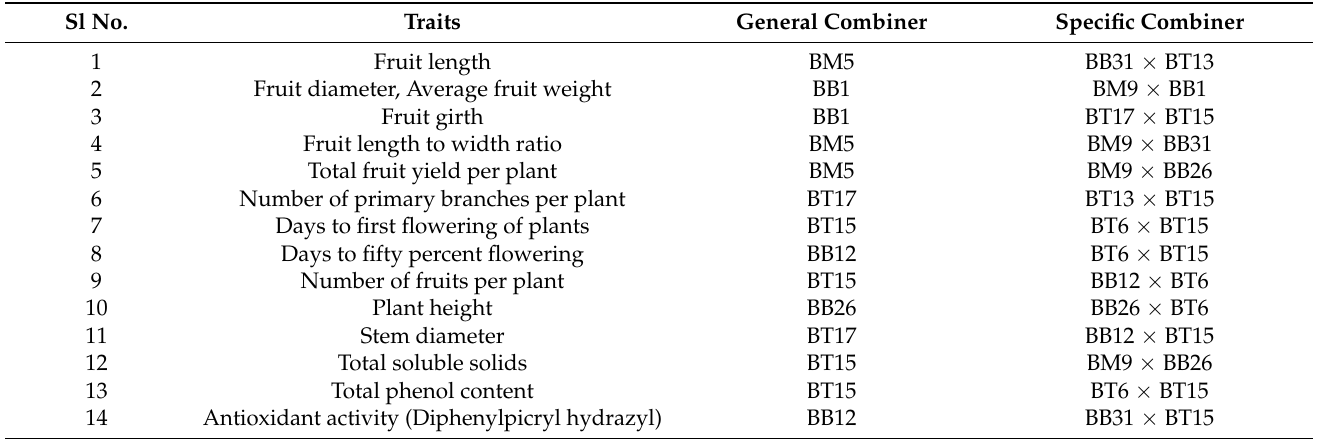
Table 8. The best general and specific combiner for 15